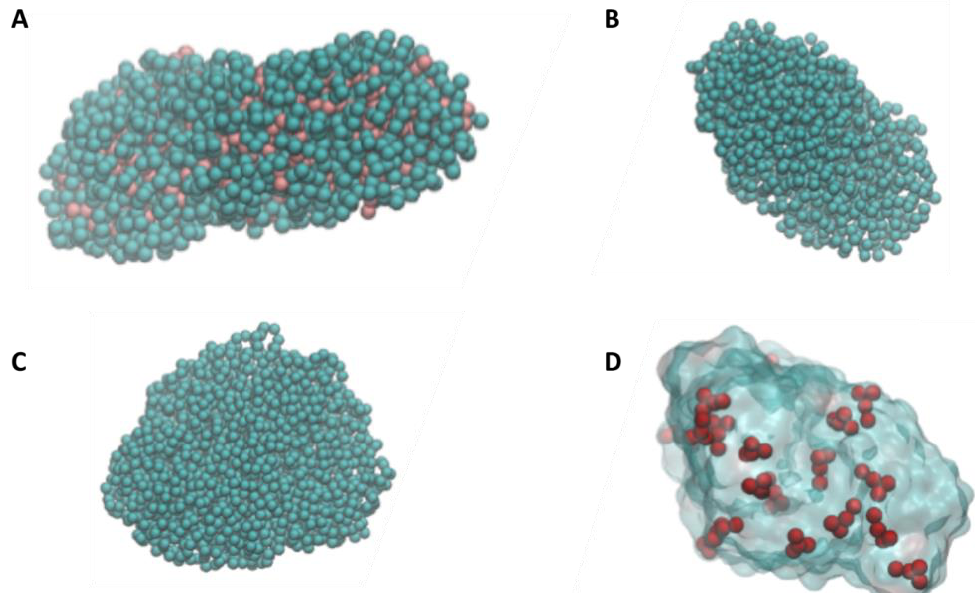
Figure 1. Representative molecular models of the different NP. ( A ) Polystyrene, where pink beads represent the (CH 2 -CH) groups, while cyan beads represent the phenyl groups; ( B ) Polyethylene; ( C ) Polypropylene; and ( D ) Polystyrene with 10% of positively charged monomers (positively charged monomers are represented in red color).